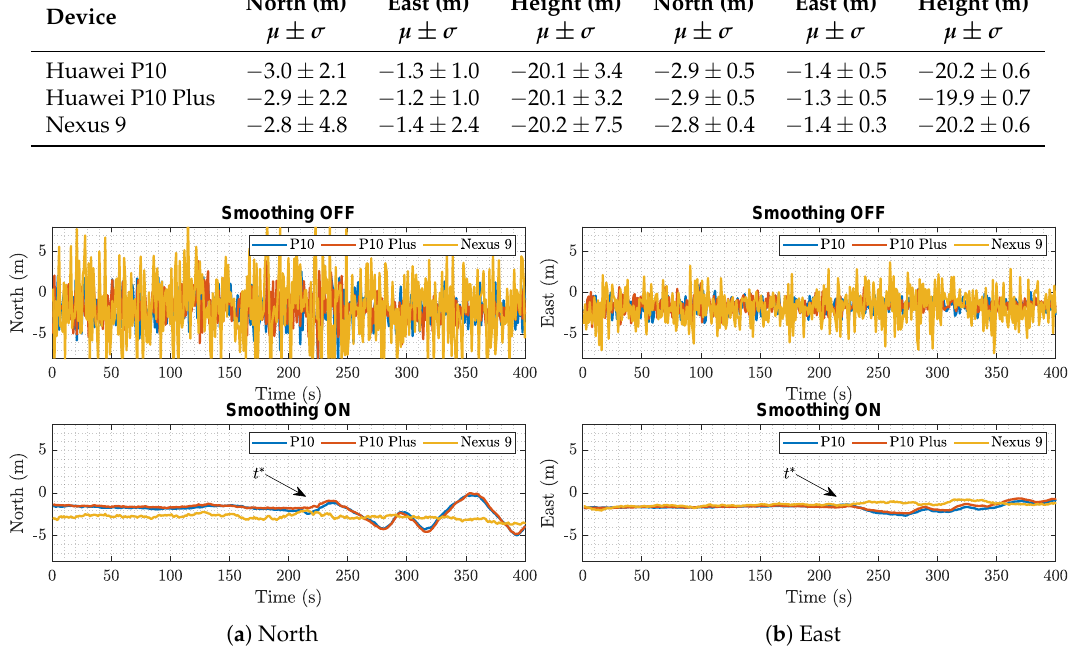
Figure 12. North ( a ) and East ( b ) position error comparison between devices in a controlled environment.